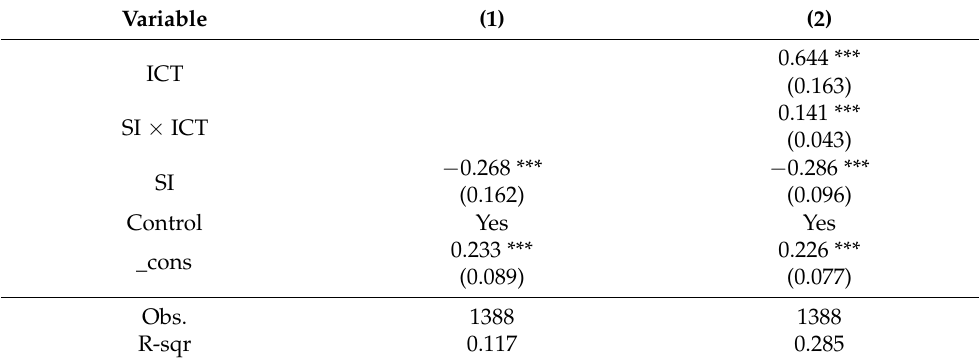
Table 4. Effect of ICTs on the relationship between land fragmentation and STFT